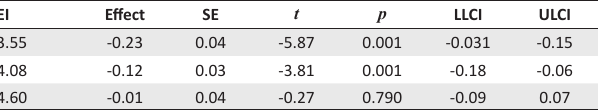
TABLE 6: Interactive effect between workplace bullying and emotional intelligence in predicting flourishing (conditional effect of workplace bullying on flourishing at the values of the moderator).